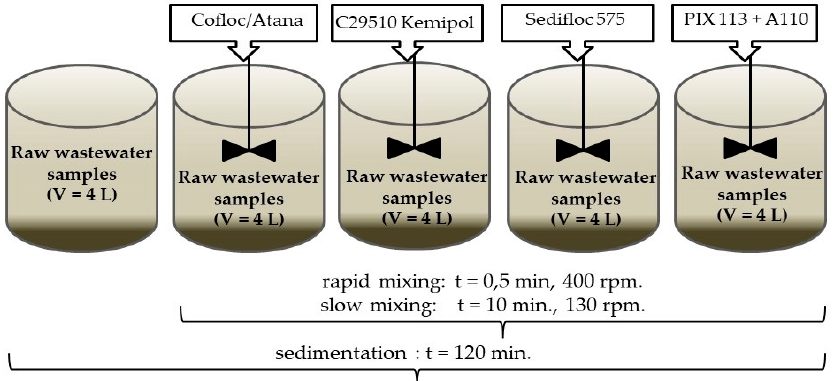
Figure 1. Measuring the effectiveness of precipitation in primary settlers—overview